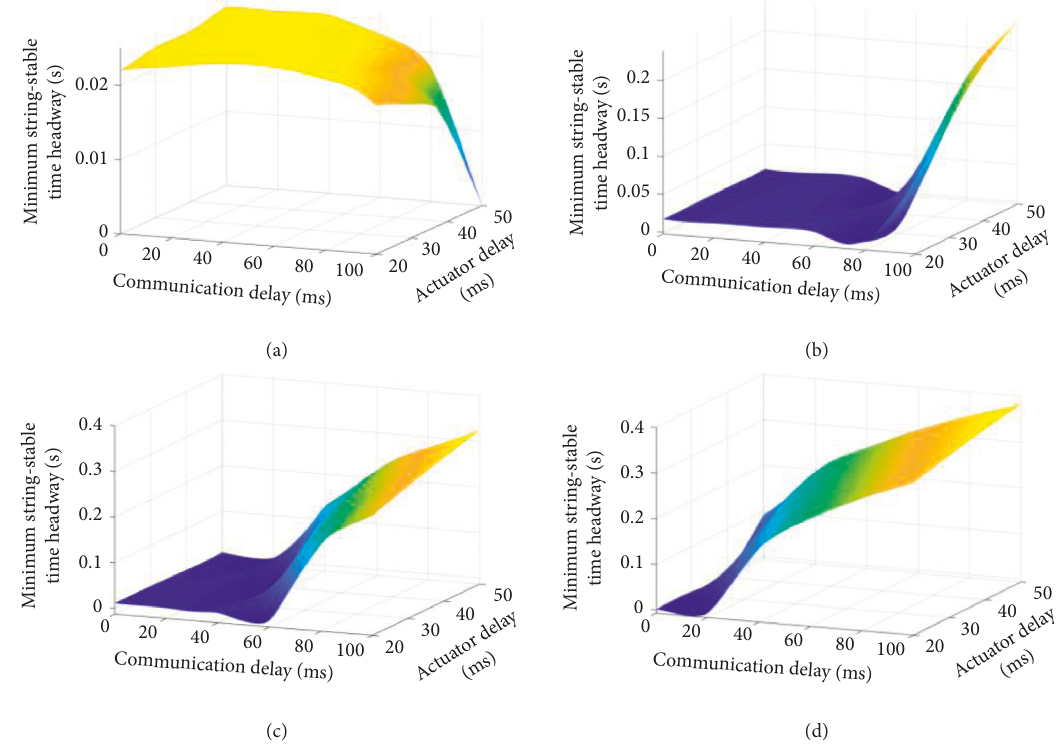
Figure 8: The minimum string-stable time headway with different estimation values of communication delay and actuator delay. (a) σ m � 100ms, β m � 50ms. (b) σ m � 75ms, β m � 40 ms. (c) σ m � 50ms, β m � 30ms, (d) σ m � 25 ms, β m � 20ms.